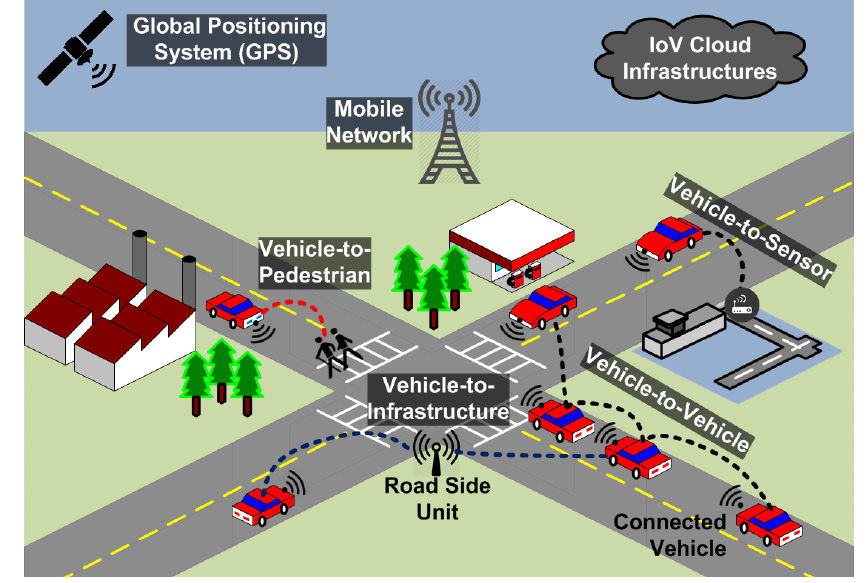
Figure 1. Smart cities communications